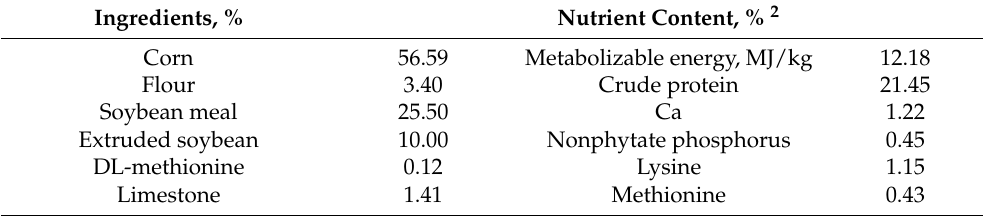
Table 1. Composition and nutrient content of basal diets for the young laying pullets (as fed basis). Ingredients,